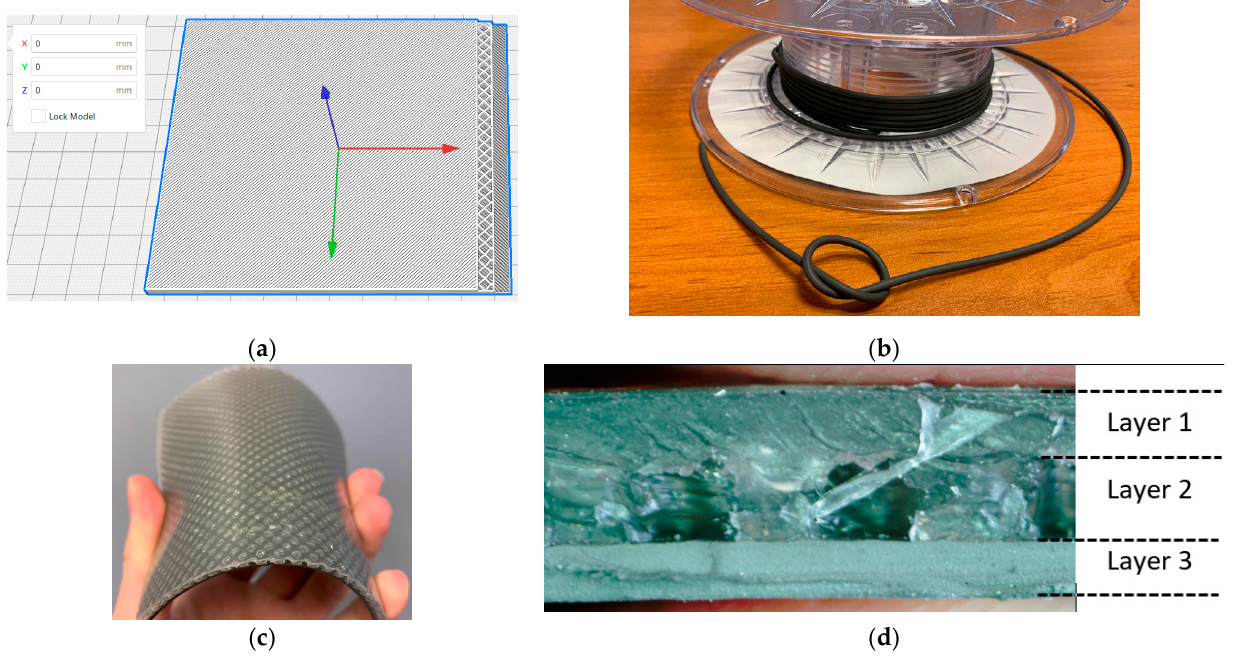
Figure 11. ( a ) Model of the multilayer structure sliced in Ultimaker Cura (white = non-loaded filament, grey = magnetic loaded filament, red axis = X, green axis = Y, blue axis = Z), ( b ) picture of the flexible composite filament, ( c ) picture of multilayer EM absorber after printing and without Table 4. Composition of the thickness measured for each printed layer. extensions, ( d ) picture of the multilayer on the side.